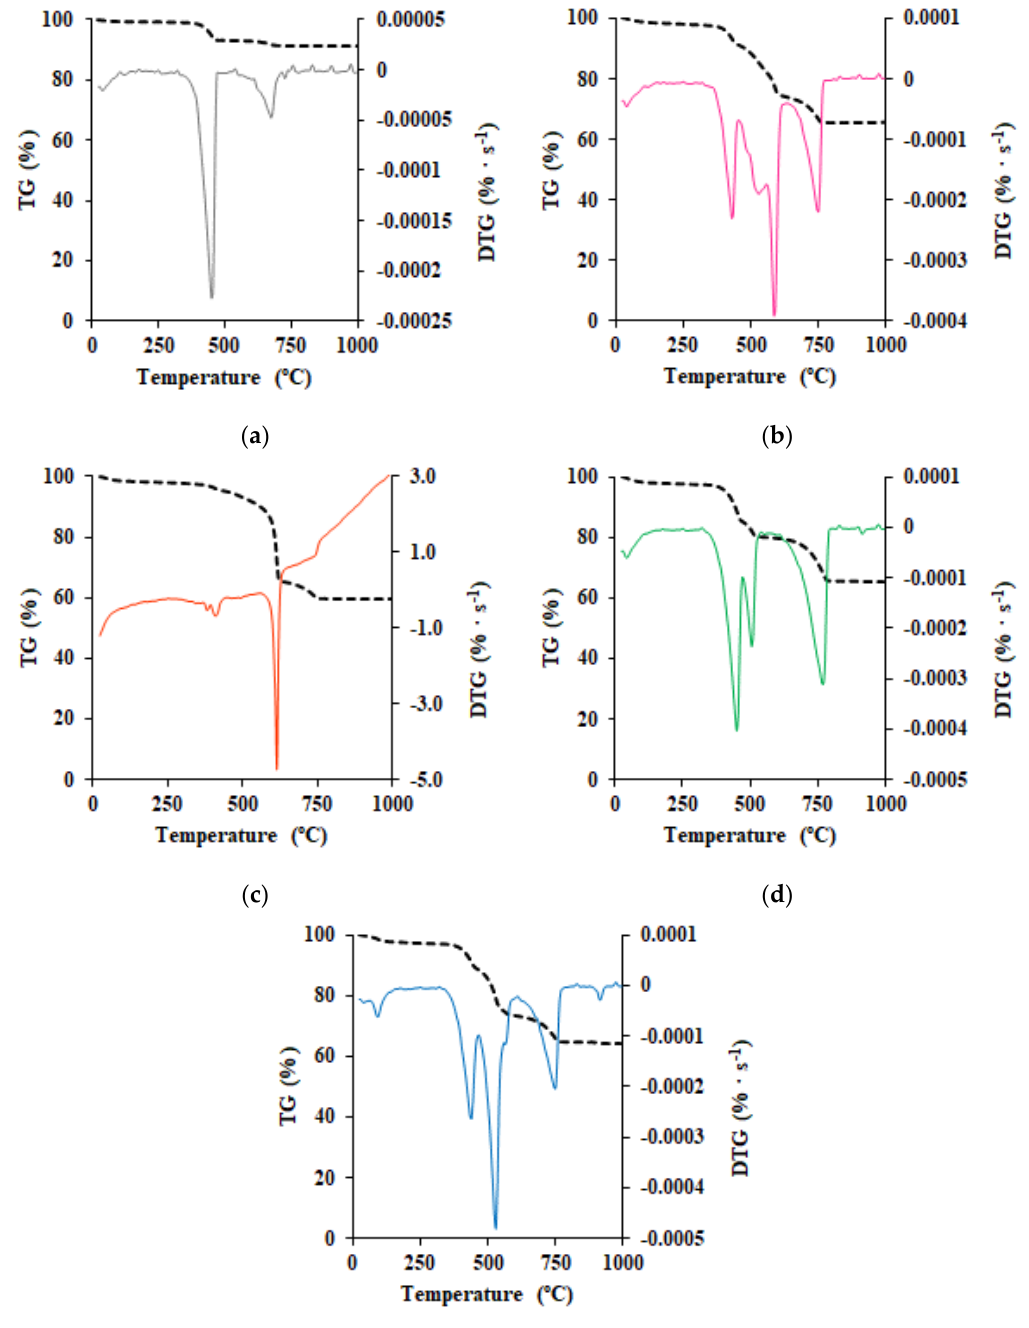
Figure 4. TG (percentage of weight loss) and DTG (derivative of weight loss) curves in an oxygen atmosphere at a heating rate of 10 C/min: ( a ) calcined eggshell, ( b ) Fe 5%, ( c ) Fe 15%, ( d ) Cu 5%, and ( e ) Cu 15%.